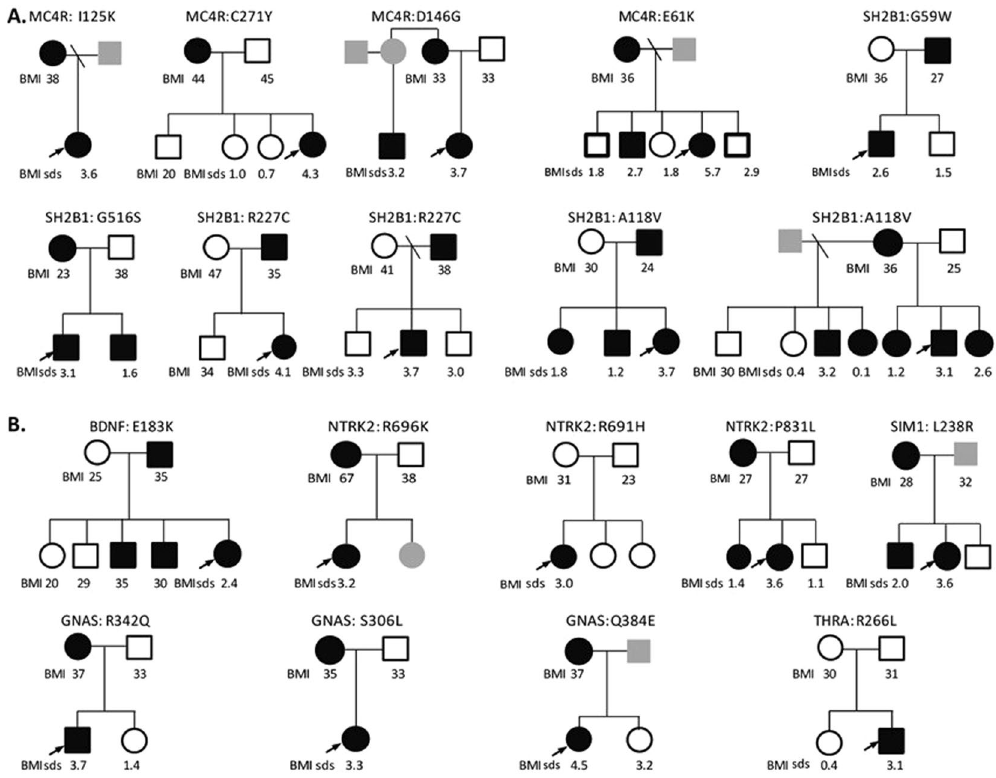
Figure 2. Pedigrees of patients with clinically associated variants contributing to obesity Co-segregation of variants is shown where male (squares) and female (circles) family members consented to genotyping. Heterozygous (filled) and wild-type (empty) mutation carriers are indicated; in some cases, individuals were not available for genotyping (grey). Body mass index (BMI) ( > 27 kg/m 2 = overweight; > 30 kg/m 2 = obesity) for adults and BMI standard deviation scores (BMI sds) for children are shown where data was available. ( A) Obesity alone; ( B) Obesity and Delay. MC4R mutations were excluded by prior Sanger sequencing of all individuals undergoing whole exome sequencing and the majority (1744/1811) of individuals undergoing targeted resequencing. The finding of four MC4R mutations in the remaining 82 individuals is in keeping with the prevalence of heterozygous MC4R mutations in this cohort as reported previously 5